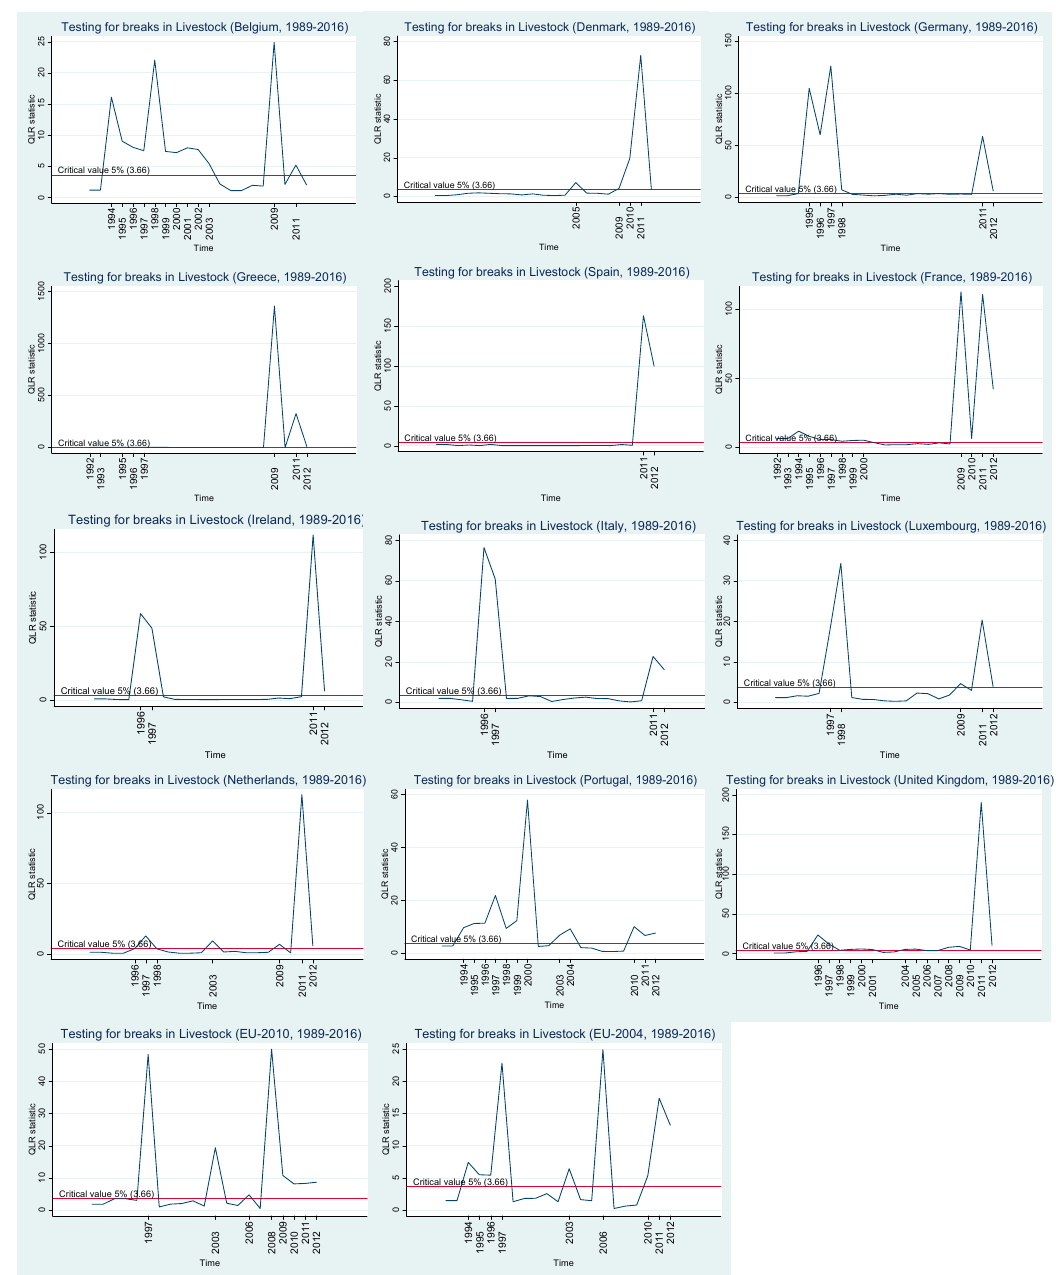
Figure 4. Testing for breaks in livestock units over the European Union countries (1989–2016).